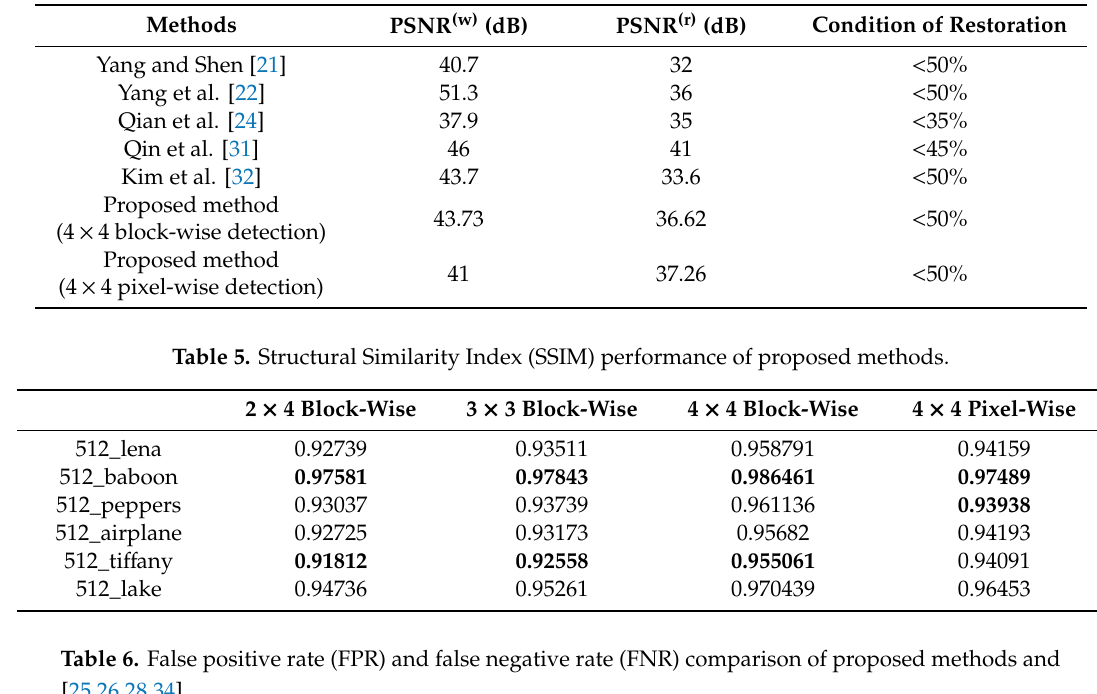
Table 4. Performance comparisons of proposed methods and [21,22,24,31,32].